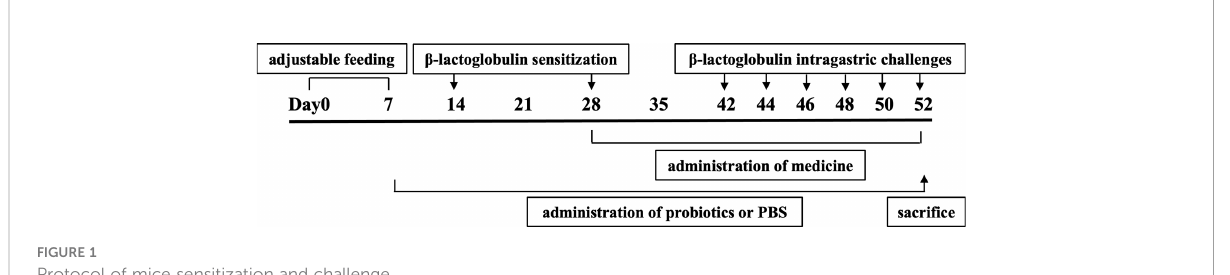
FIGURE 1 Protocol of mice sensitization and